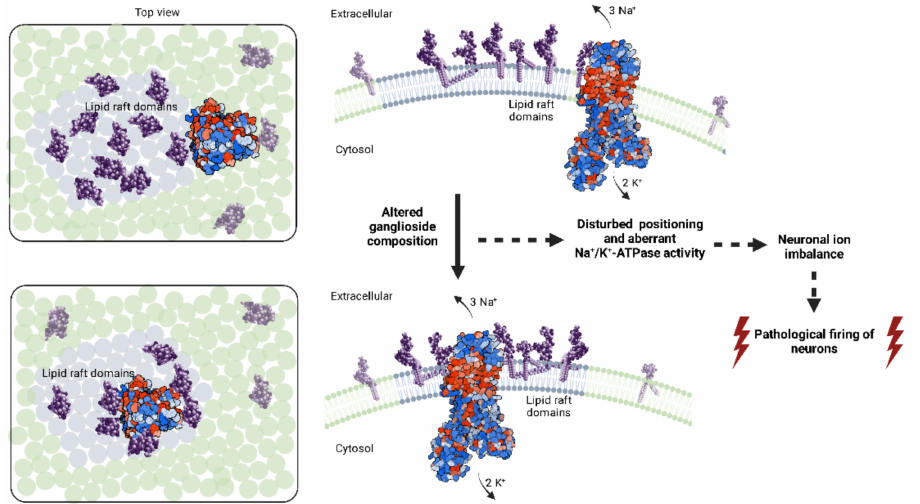
Figure 1. Schematic representation of sequence of events leading from altered ganglioside compo- sition of the neuronal membrane to pathological firing of neurons and epileptic seizures. Na + /K + - ATPase (NKA) positioning is heavily influenced by the surrounding gangliosides. NKA is represented by Biorender.com (accessed on 26 April 2022), relying on PDB accession code 3B8E, according to [134], utilizing the Van Der Waals structure style and Hydrophobicity color style. Red color represents amino acids with more hydrophobic side chains, and blue represents amino acids with more hydrophilic side chains. Gangliosides (in space-filling model) are shown in